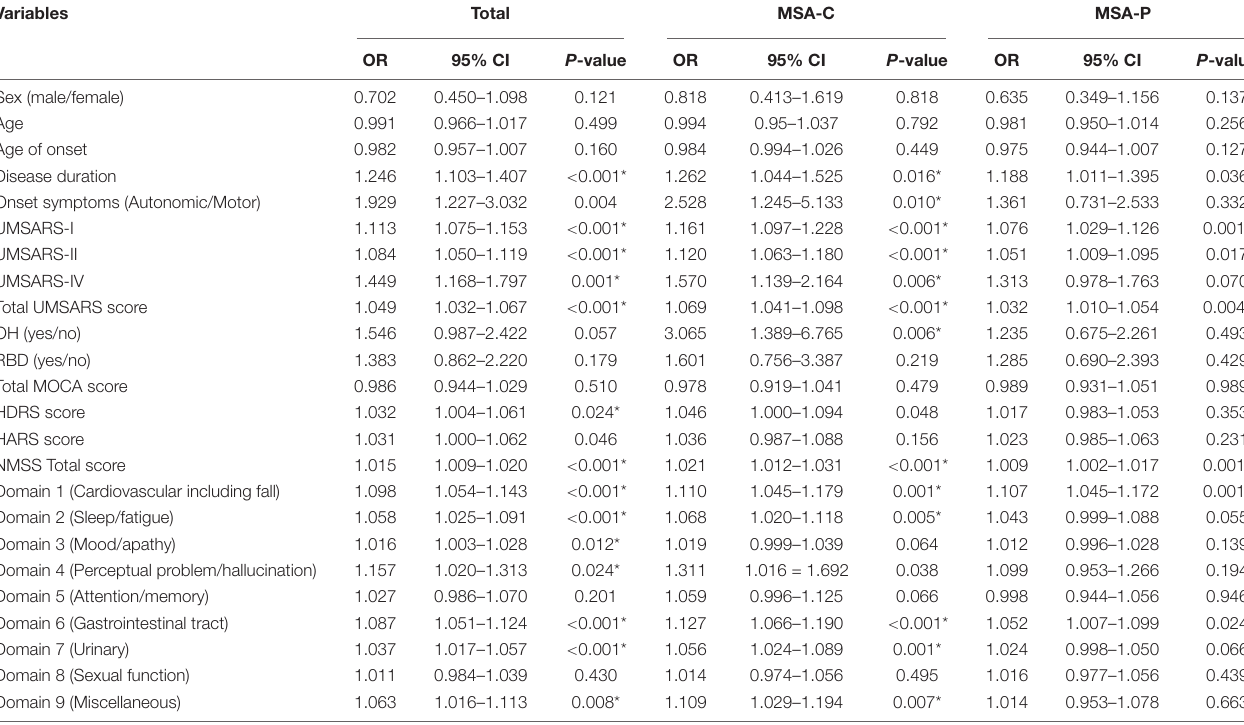
TABLE 3 | Factors associated with CHS in MSA, MSA-P, and MSA-C patients in univariate regression model. Variables